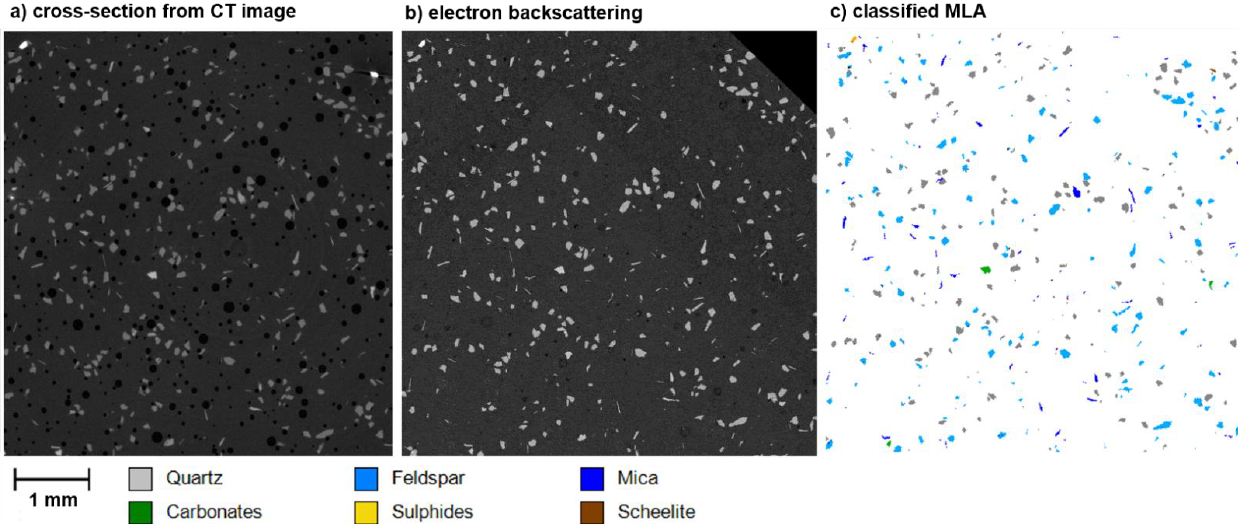
Figure 9. Overview of the correlation between a cross-section of the 3D image with the same slice analysed by electron backscattering and corresponding mineral classification by MLA of the Scheelite ore sample. The most common phases and microstructures are highlighted.